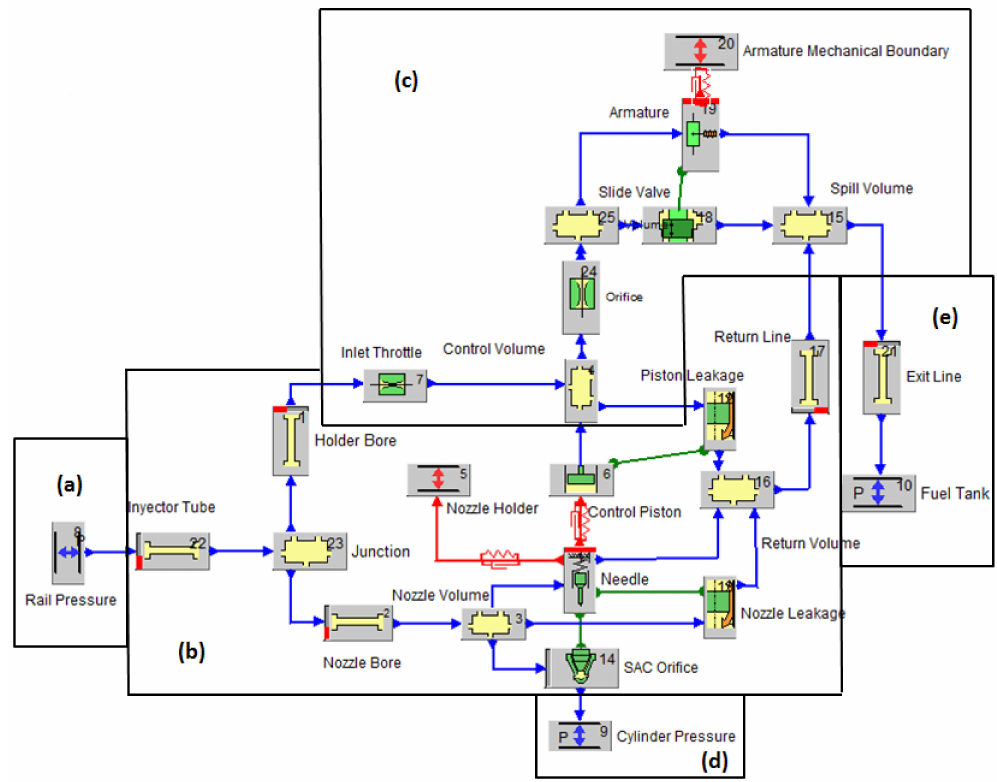
Figure 2. 1D Model of tested injector. ( a ) Rail Pressure; ( b ) Injector Body; ( c ) Solenoid Valve; ( d ) In-Cylinder Pressure; ( e ) Return line the fuel tank.